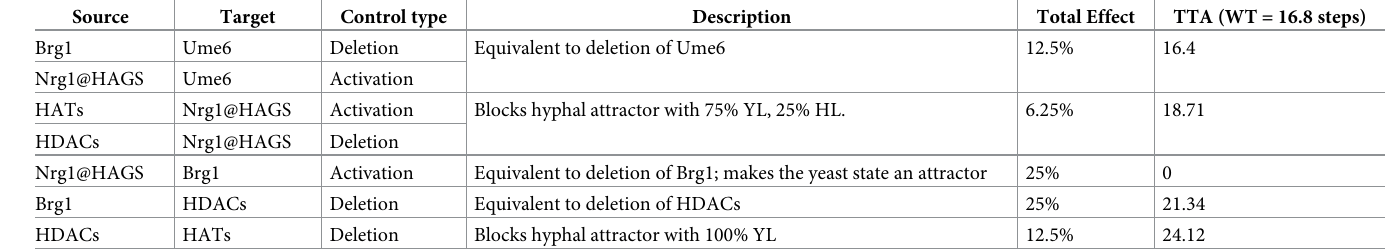
Table 5. Edge perturbations predicted by algebraic control to block the YHT. Total effect measures the percent change in the state transition graph, and time to absorp- tion (TTA) measures how long it takes to reach an attractor, starting from the yeast state, setting pH =